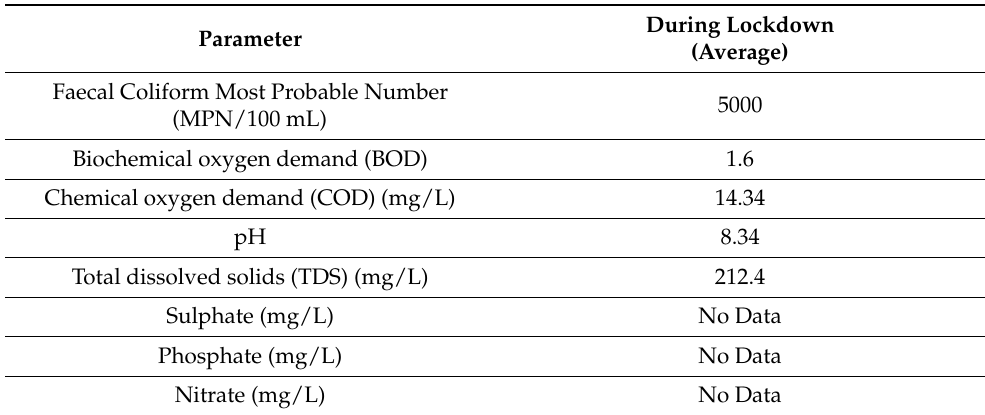
Table 1. Average concentration/value of different parameters at thirteen locations during lockdown period in middle reaches of Ganges river.